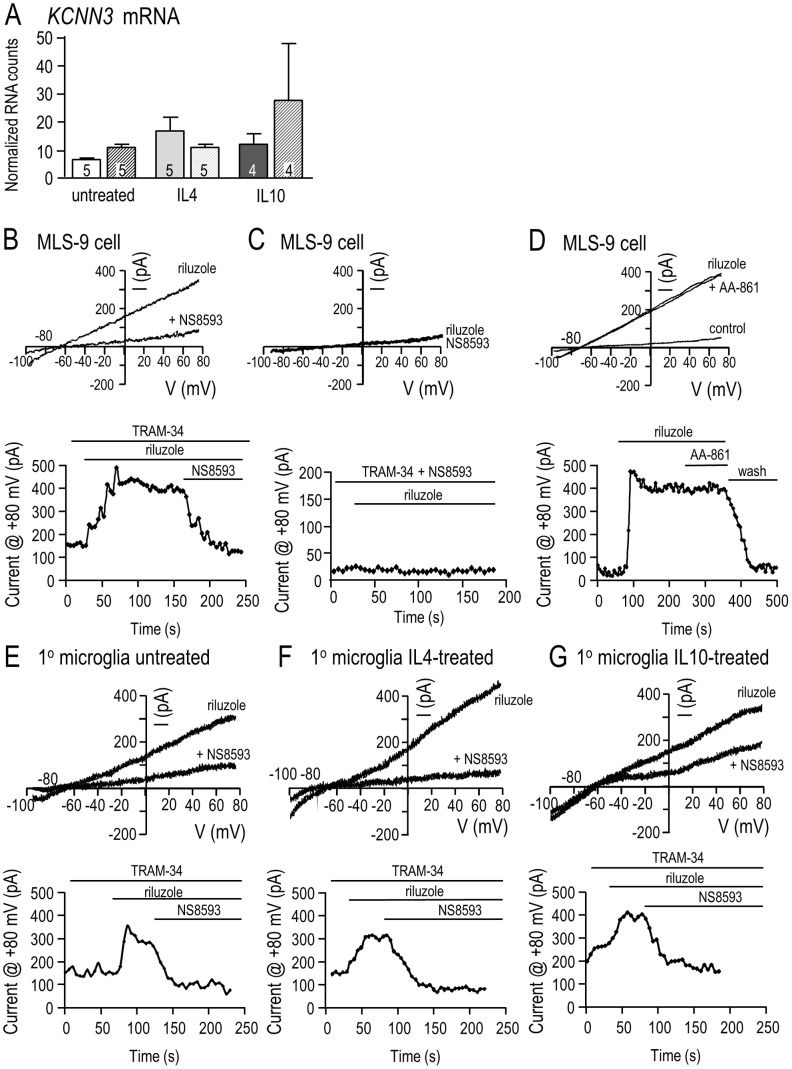

KCNN3 expression and KCa2.3 current inhibition by NS8593 in microglia in differing activation states.
A. Expression of KCNN3 mRNA was quantified using NanoString nCounter analysis in unstimulated primary microglia, and at 6 hr (solid bars) and 24 hr (striped bars) after treatment with 20 ng/ml IL4- or IL10-treatment. B–D. NS8593 inhibits the KCa2.3 current, while AA-861 has no effect. KCa2.3 currents were recorded from MLS-9 microglial cells in the perforated-patch configuration produced by amphotericin B (200 µg/ml) in the pipette. The voltage protocol throughout was a 120 ms-long voltage ramp from −100 to +80 mV from a holding potential of −70 mV. The bath always contained 1 µM TRAM-34 to block KCa3.1 currents. Riluzole (300 µM) was used simply as a tool to activate the KCa2.3 current [21]. B.
Upper panel: Representative traces show the current evoked by riluzole with or without 7 µM NS8593. Lower panel: The representative time course (current measured at +80 mV) illustrates KCa2.3 current activation and its inhibition by NS8593. C. Representative currents and time course show that no current was activated when 7 µM NS8593 was present in the bath. D. The current is insensitive to 10 µM AA-861. Note that current activation by riluzole is readily reversible (wash), as we previously showed [21]. E–G. The KCa2.3 current in primary rat microglial cells is inhibited by 7 µM NS8593 under differing activation states. Currents were recorded using the same patch-clamp configuration as described for MLS-9 cells. Upper panels: Representative currents in microglia that were unstimulated (E), or treated for 24 hr with 20 ng/mL IL4 (F) or 20 ng/mL IL10 (G). Lower panels: A representative time course for each cell (current at +80 mV) shows activation by riluzole and inhibition by NS8593.